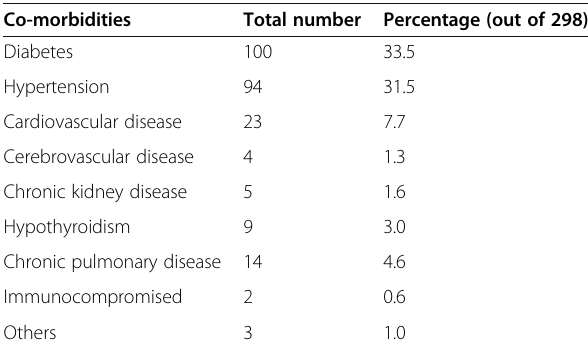
Table 3 Comorbidities/risk factors of patients with COVID-19 pneumonia